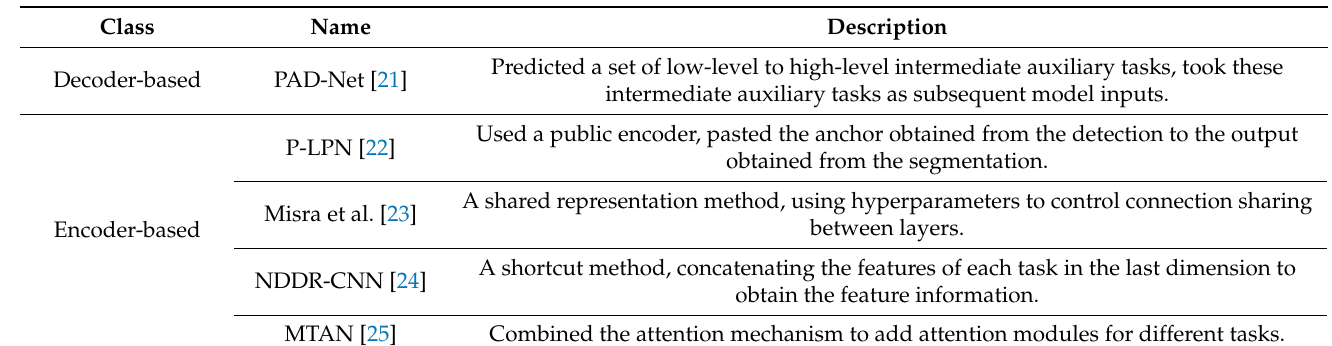
Table 4. The description of decoder-based multitask network and encoder-based multitask network.